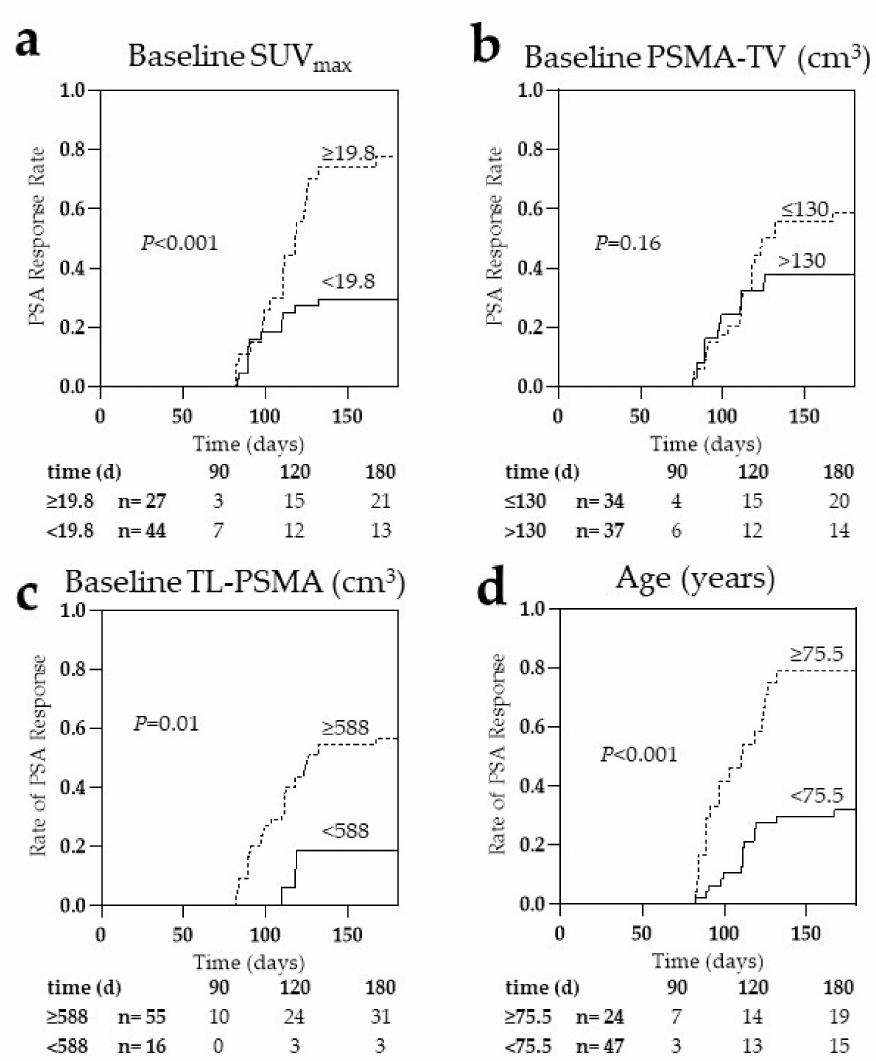
Figure 2. Kaplan–Meier curves for early prostate-specific antigen (PSA) response, using maximum standardized uptake value (SUV max ) ( a ), prostate-specific membrane antigen-based tumor volume (PSMA-TV) ( b ), total lesion (TL)-PSMA ( c ), and age ( d ) prior to radioligand therapy. Higher SUV max , age, and TL-PSMA were significantly associated with the PSA response, whereas PSMA-TV was not significantly associated. d =